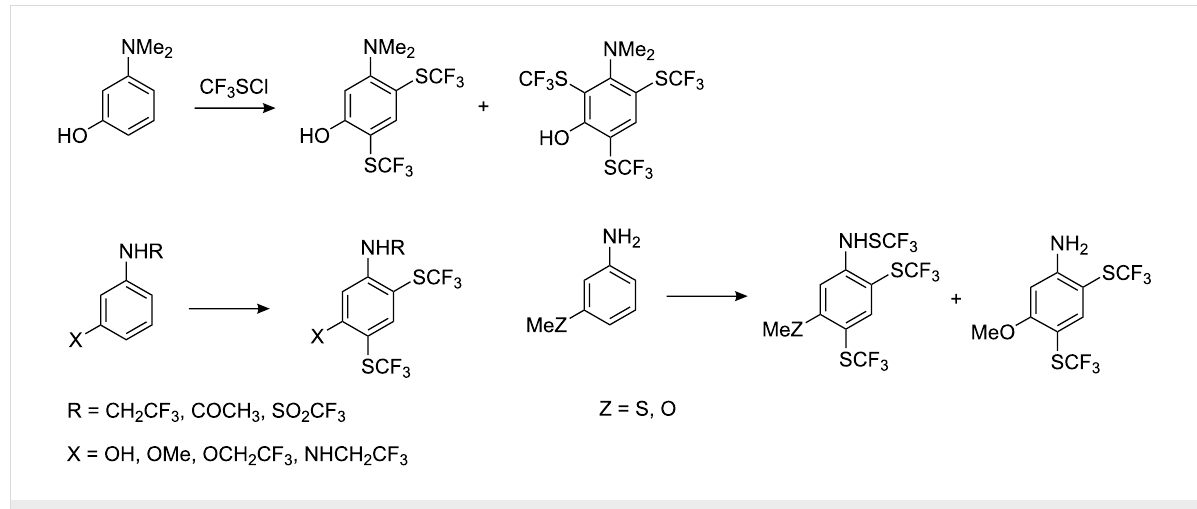
Scheme 11: Trifluoromethylsulfanylation of anilines with electron-donating groups in the meta position [74].